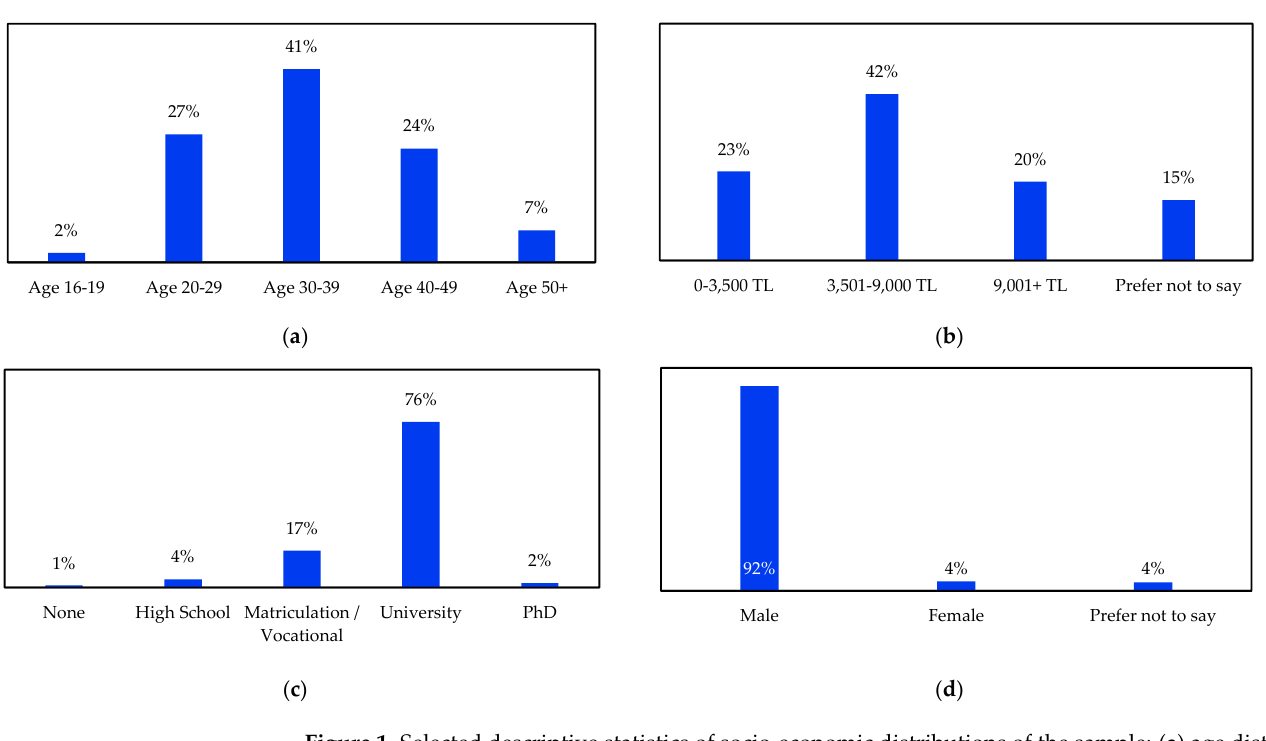
Figure 1. Selected descriptive statistics of socio-economic distributions of the sample: ( a ) age distri- bution; ( b ) income distribution; ( c ) education distribution; ( d ) gender distribution. N = 715 Turkish cryptocurrency owners. TL = Turkish lira.